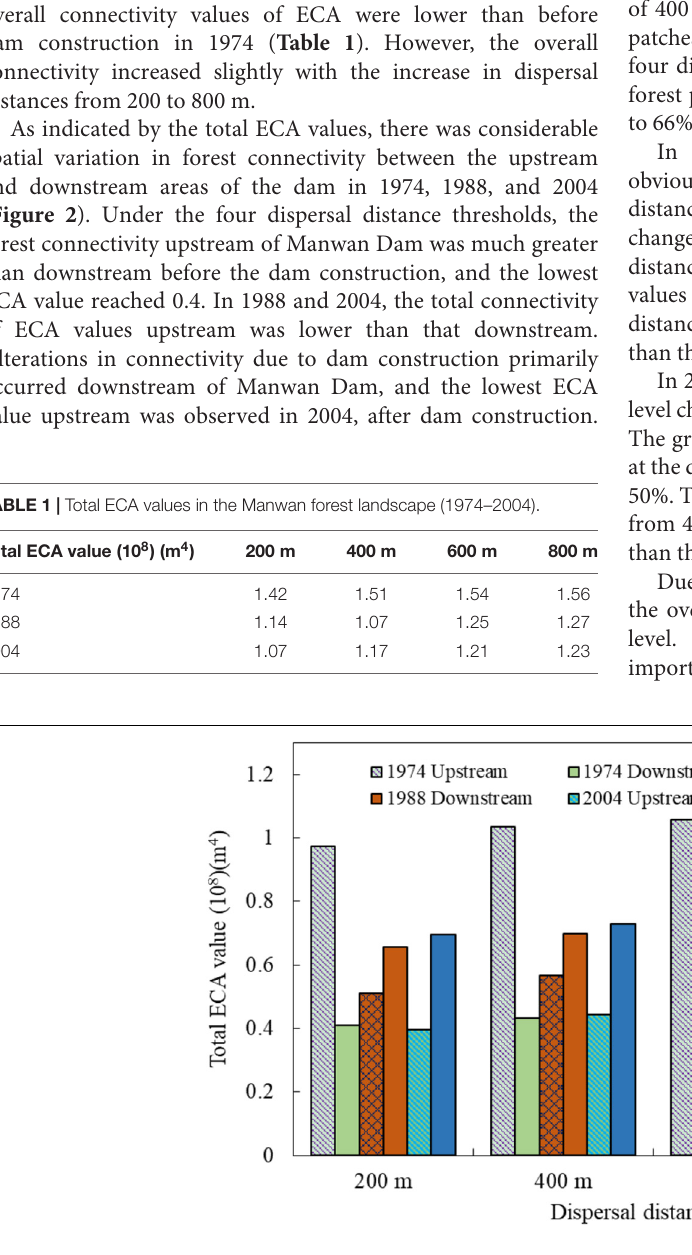
FIGURE 2 | Spatial differences in total landscape connectivity as measured by the ECA index (1974–2004).